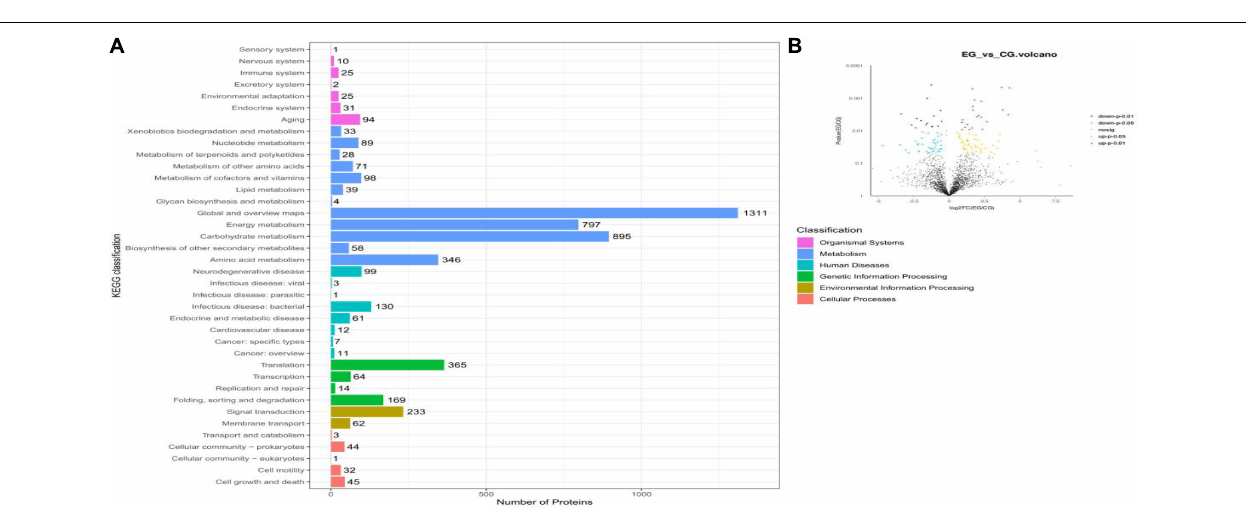
FIGURE 3 | Metaproteomics analyses of proteins in the rumen fluid microbiota of beef cattle fed a CrPyr supplementation diet. (A) KEGG classification. (B) Volcano plots of differentially expressed proteins between EG and CG. EG, experimental group, diet supplemented with 60 g/day CrPyr; CG, control group. Each dot represents the mean expression level ( n = 3) of a single protein. The yellow dots indicate the significantly up-regulated proteins at the P < 0.05 level, the red dots indicate the significantly up-regulated proteins at the P < 0.01 level, the light blue dot indicates the significantly down-regulated proteins at the P < 0.05 level, and the blue dot indicates the significantly down-regulated proteins at the P < 0.01